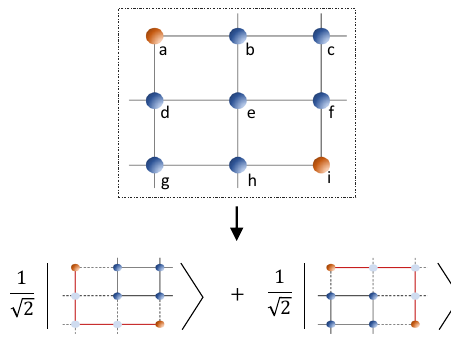
Fig. 7 Superposition of paths. Given some resource state (e.g., 2D cluster state) connecting several nodes in a network, a